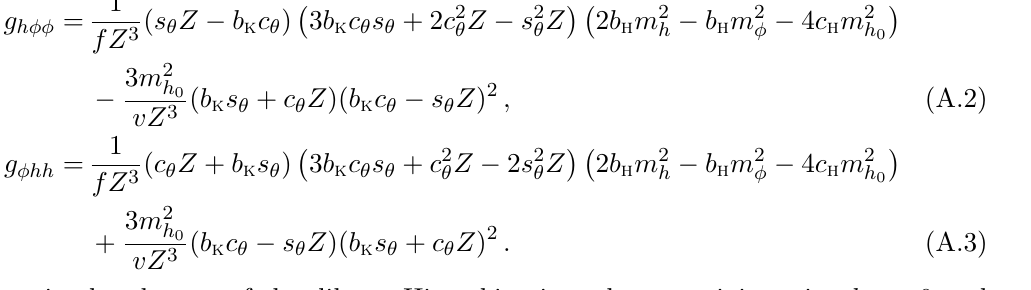
Note that in the absence of the dilaton-Higgs kinetic and mass mixings, i.e. b c = 0 (hence s = 0, Z = 1, b = 1, c = 1), the above trilinear couplings simplify m h h (cid:18)